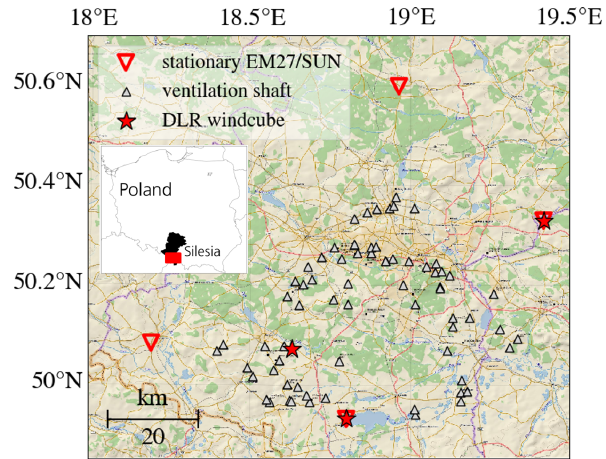
Figure 1. The USCB in southwest Poland. The small inset on the left illustrates the region of Silesia in black and the map excerpt of the USCB in red. Ventilation shafts are marked as grey triangles. Stationary EM27/SUN FTS locations are marked as red triangles; the three wind lidars DLR85, DLR86, and DLR89 are marked as red stars. Eastern and southern wind lidars are placed at the same loca- tions as the respective EM27/SUN instruments. The western wind lidar is located about 30km to the east of the western EM27/SUN. Background map from ESRI